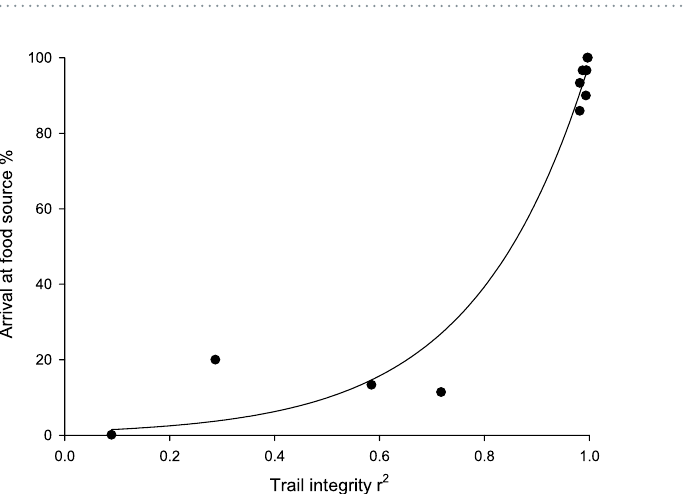
Figure 1. Trail following measured by trail integrity statistic ( A ) and percentage arrival success to food ( B ) of the Argentine ant Linepithema humile to dilutions of total gaster extract ( □ ) or dilutions of synthetic ( Z )-9- hexadecenal ( ■ ). Error bars show one standard error.